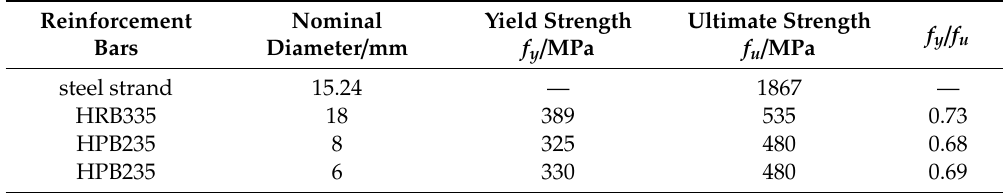
Table 2. Experimental results of various reinforcement bars.